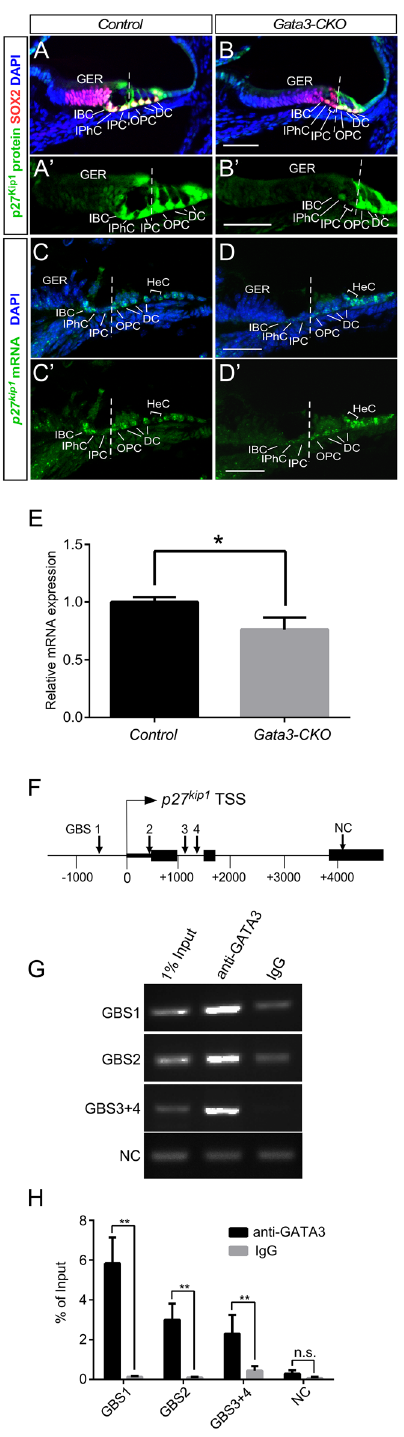
Figure 5. GATA3 binds to the p27 kip1 promoter and is required for its expression in the cochlea. ( A , B , A ′ , B ′ ) Gata3 deletion leads to the downregulation of p27 kip1 expression (green) in IPCs, IBCs, and the lateral GER at P4 but not that of SOX2 (red). The middle turn of cochlea is shown. ( C , D , C ′ , D ′ ) RNAscope in situ hybridization shows the expression level of p27 kip1 mRNA was decreased in Gata3 -CKO mice cochleae at P4 after the administration of tamoxifen at P1 and P2. ( E ) RT-qPCR result shows that the expression of p27 kip1 is significantly reduced in Gata3- CKO cochleae. n = 3; *p < 0.05. ( F ) Schematic drawing depicts the putative GATA3-binding sites (GBSs) of the p27 kip1 promoter. ( G ) ChIP-PCR results show that anti-GATA3 immunoprecipitation specifically enriched the GBS-containing sequences. Control IgG and a coding region within exon 3 containing no GBS are used as negative controls for the ChIP-PCR analysis. ( H ) The results of ChIP-qPCR confirm that these predicted GBS-containing sequences are significantly enriched by ChIP with anti-GATA3. n = 4; n.s . not significant; **p < 0.01. Scale bar 50